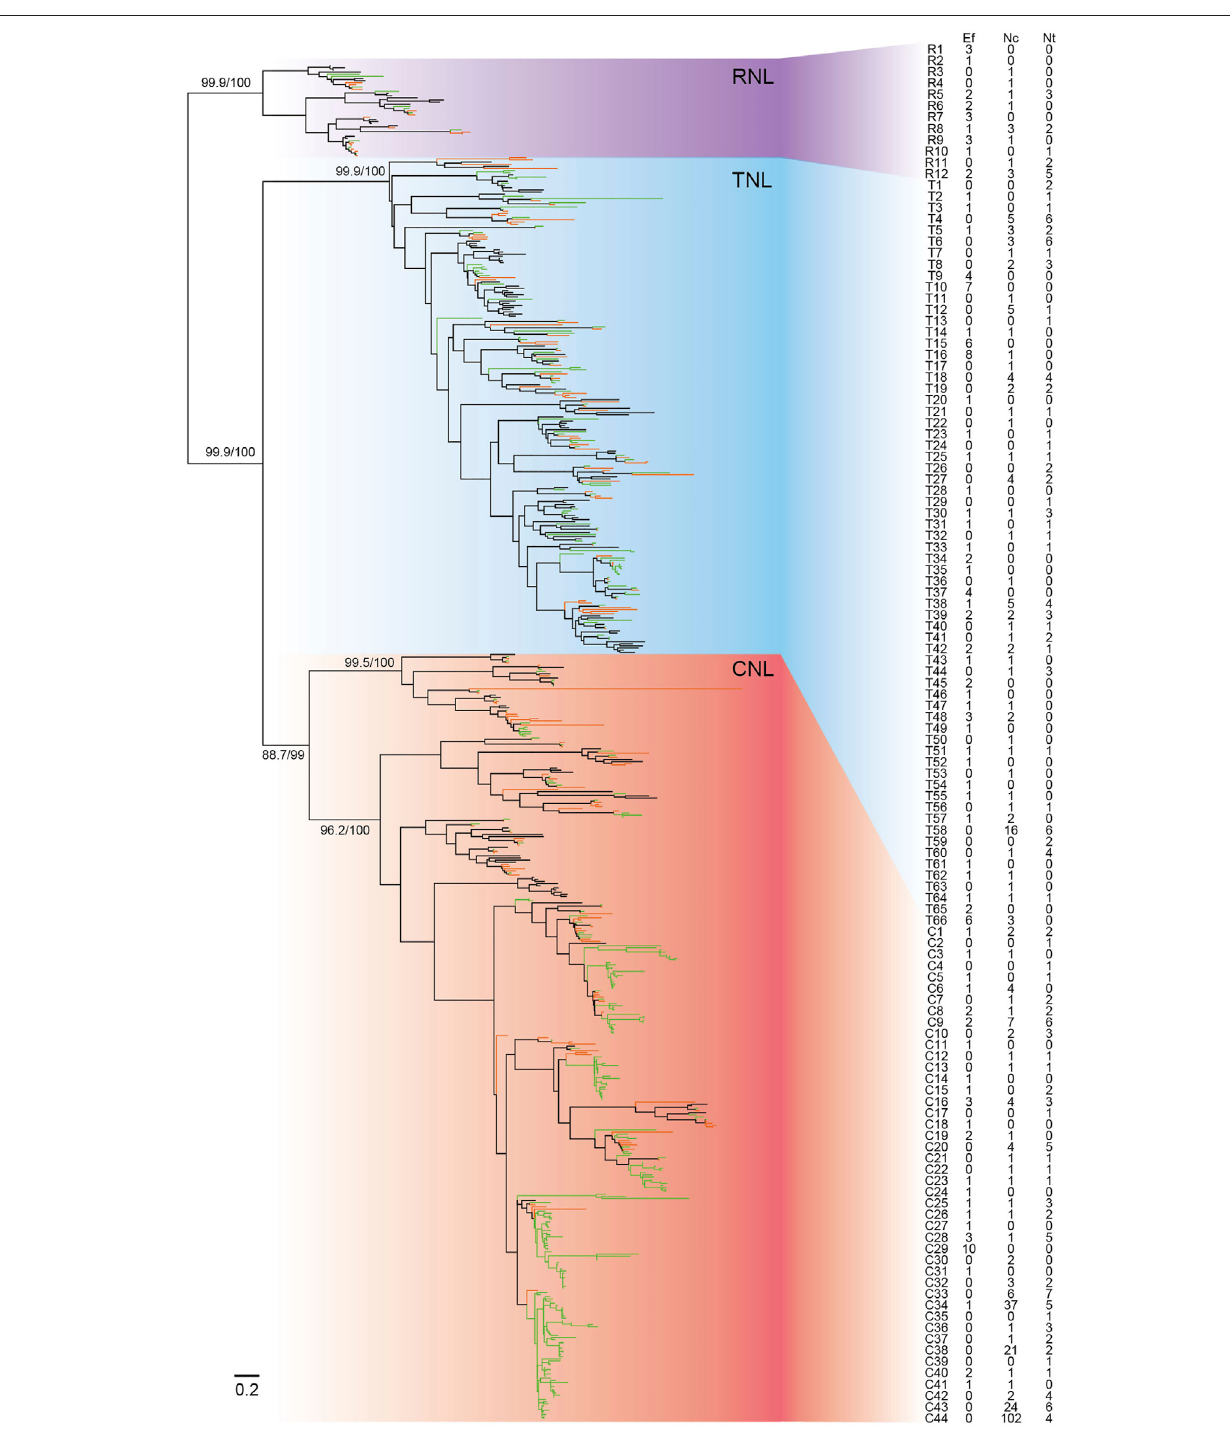
Frontiers in Genetics |